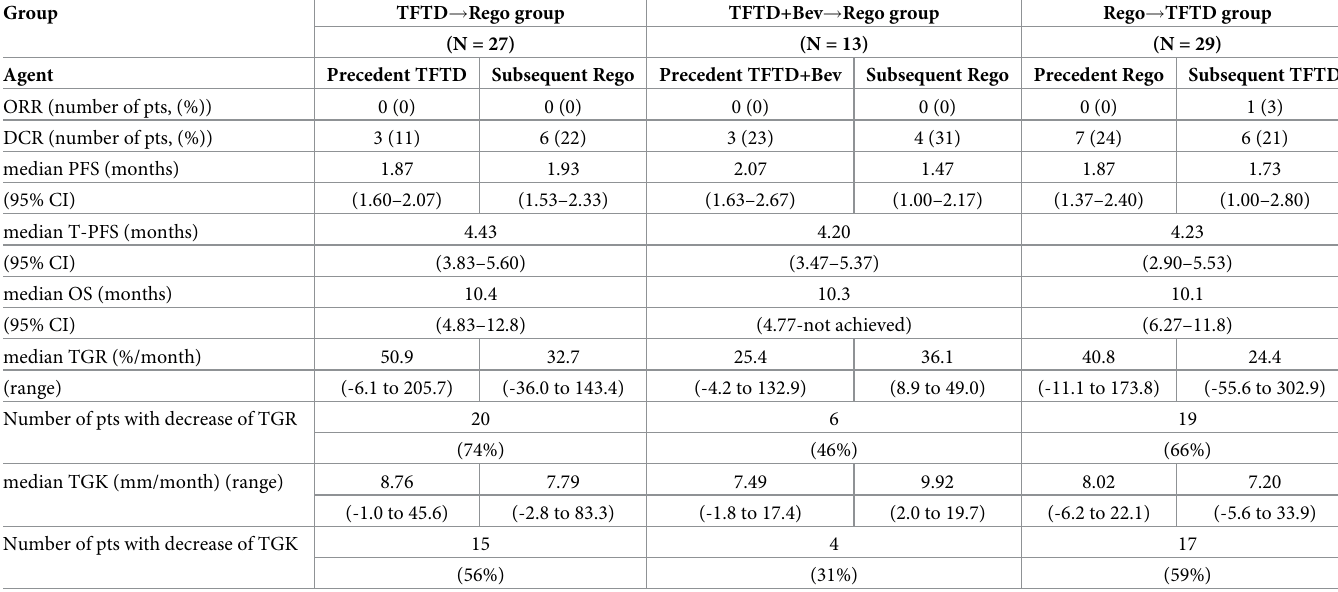
Table 2. Summary of the